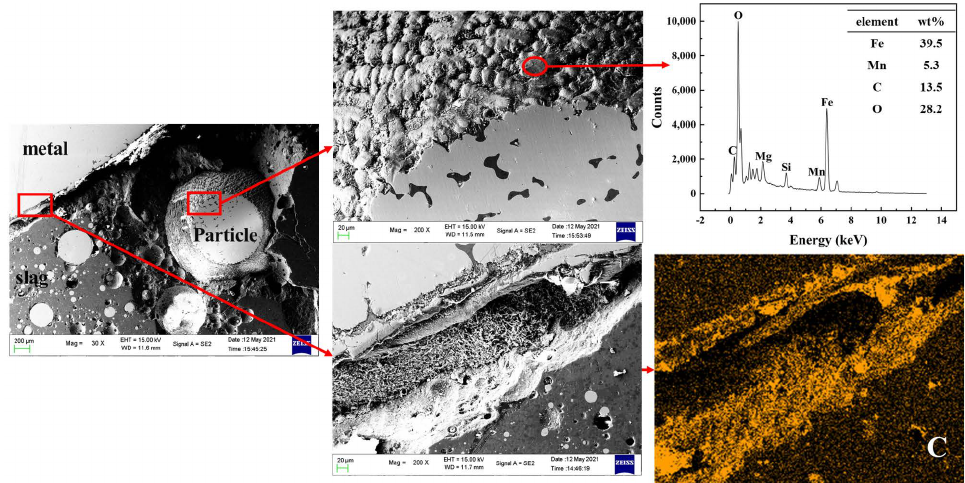
Figure 13. Interfacial morphology and EDS analysis at 10 min between Fe-13Mn-5Al alloy and low SiO 2 slag.